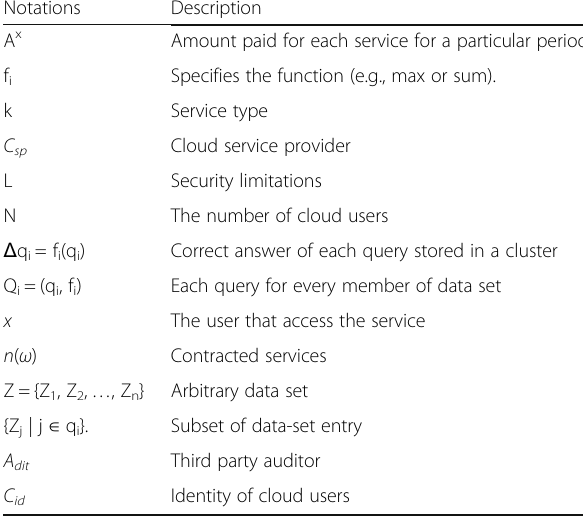
Table 1 System parameters and definitions for service